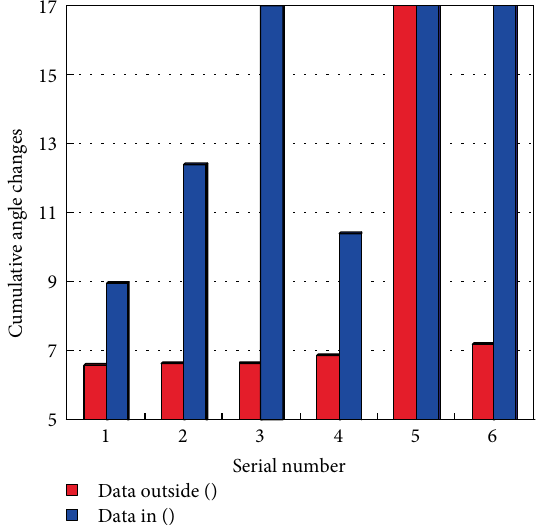
Figure 13: A comparison chart of Δ𝜃 sum when there are 3 or more